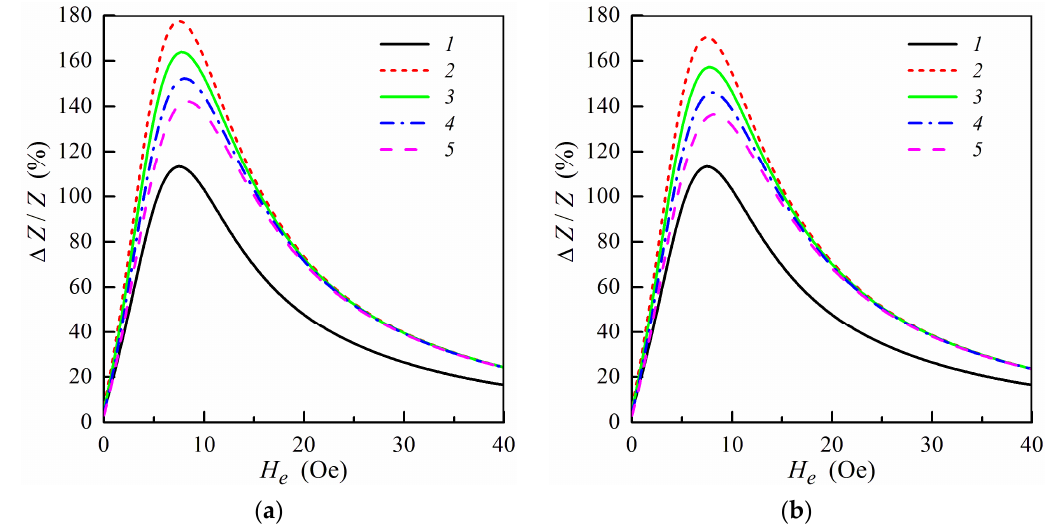
Figure 2. MI ratio ∆ Z / Z as a function of the external field H e at f = ω /2 π = 100 MHz for the multilayered element with ferrogel placed onto the surface of thin layer ( m = 3, n = 4) ( a ) and onto the surface of thick layer ( m = 4, n = 3) ( b ) (see also Figure 1e,f). Curves 1, multilayered film without gel; curves 2, film with pure gel (hydrogel) ( H p = 0); curves 3, H p = 0.25 Oe; curves 4, H p = 0.5 Oe; curves 5, H p = 0.75 Oe. Parameters used for calculations are l = 1 cm, w = 0.2 mm, 2 d 0 = 500 nm, d 1 = 3 nm, d 2 = 100 nm, M = 750 G, H a = 6 Oe, ψ = − 0.1 π , σ 0 = 5 × 10 17 s − 1 , σ 1 = 5 × 10 16 s − 1 , σ 2 = 3 × 10 16 s − 1 , κ = 0.02, d 3 = 1 mm, H c = 6.5 Oe, H 1 = 750 Oe and ε = 80.